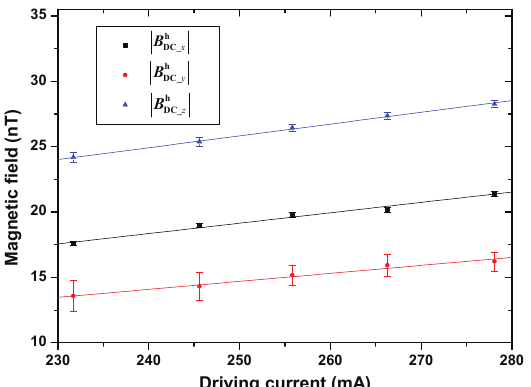
(cid:12) (cid:12) (cid:12) (cid:12) (cid:12) (cid:12) h_DC h_DC h_DC (cid:12) (cid:12) (cid:12) (cid:12) (cid:12) (cid:12) x y z (cid:12) B (cid:12) , (cid:12) B (cid:12) , and (cid:12) B (cid:12) ) as a